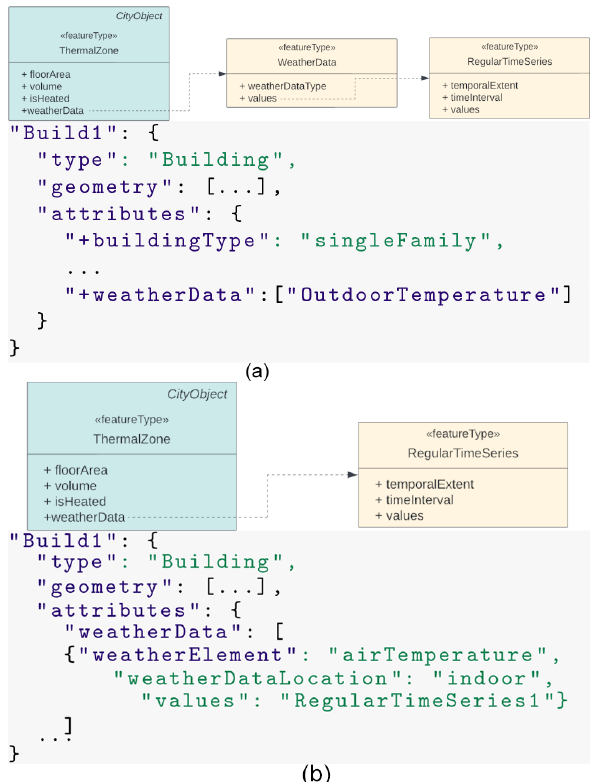
Figure 11. Storage of WeatherData (a) as a JSON object, and (b) a subschema.